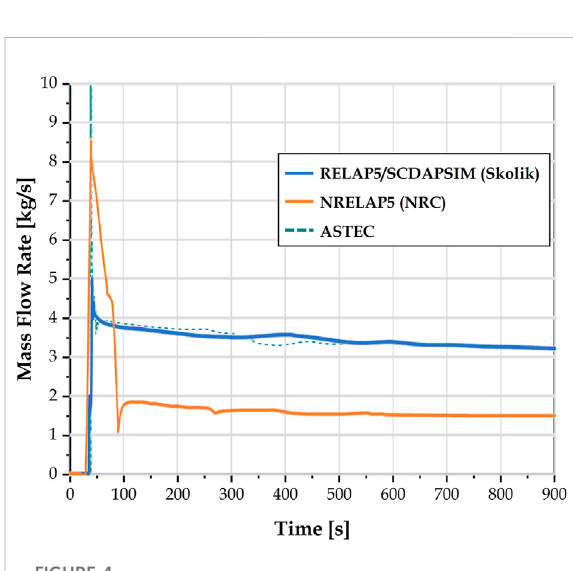
FIGURE 4 Turbine trip transient: DHRS total mass fl ow rate of both liquid and vapor phases. This fi gure zooms in on values below 10 kg/s for direct comparison with references. Refer to text for detailed discussion on the peak excluded from this fi gure.